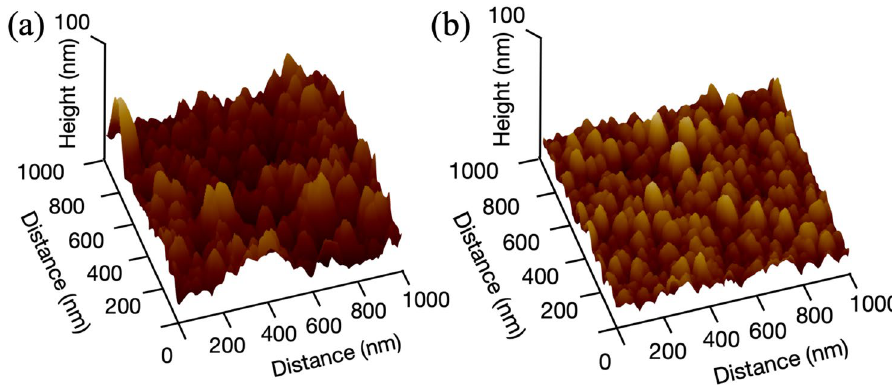
Figure 4. AFM images of surface on carbon films deposited on sapphire substrates in ( a ) oxygen and ( b ) carbon dioxide